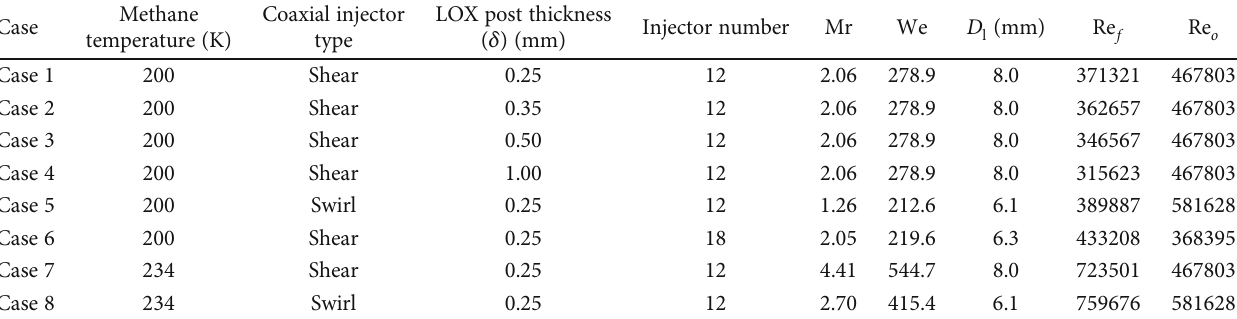
Table 1: The fl uid and structure parameters of each case.